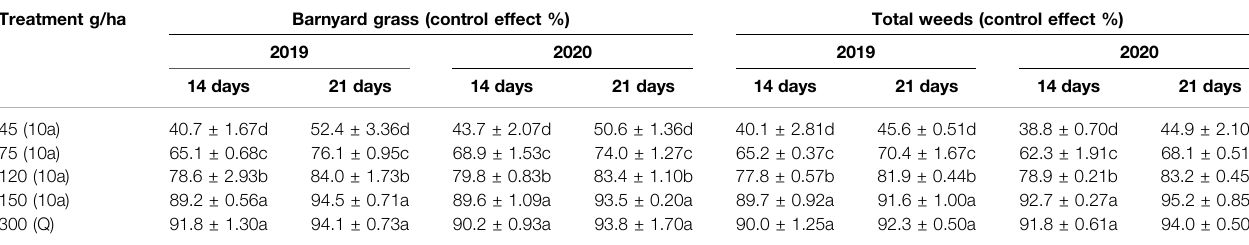
TABLE 3 | Weed control effects after 14 and 21 days of treatment at different dosages of 10a and quinclorac. Treatment g/ha Barnyard grass (control effect